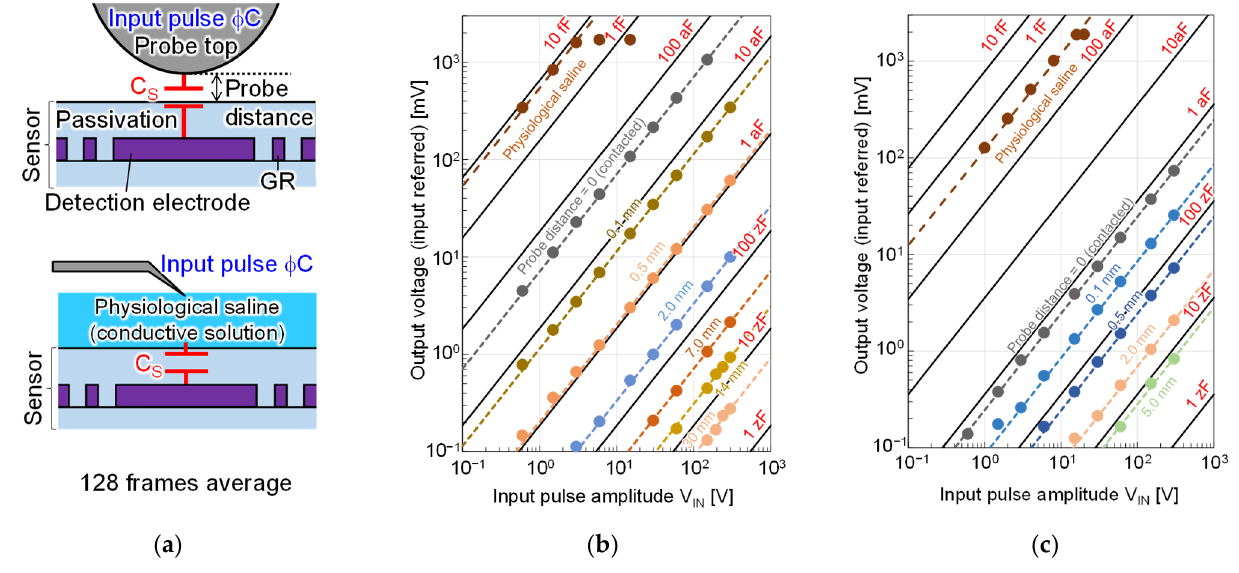
Figure 11. Measured transfer characteristics of the two chips: ( a ) measurement methods; ( b ) Chip A; ( c ) Chip B.